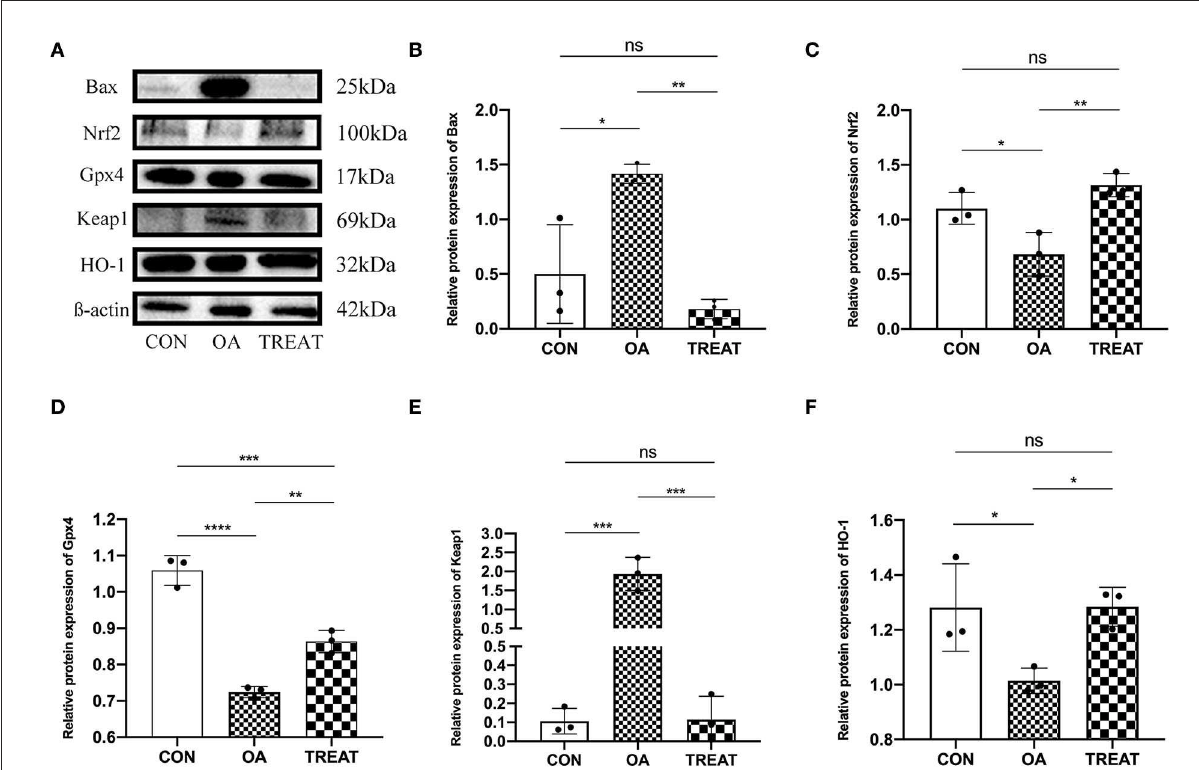
FIGURE6 Effect of the oral administration of live combined Bacillus subtilis and Enterococcus faecium on the OA colonic protein expression of Bax, Nrf2, Gpx4, Keap1, and HO-1. (A) Protein expressions detected via western blot. (B–F) . Protein expression analysis of Bax, Nrf2, Gpx4, Keap1, and HO-1. All data are expressed as the mean ± SD. * p < 0.05, ** p < 0.01, *** p < 0.001 and **** p < 0.0001; n = 3.